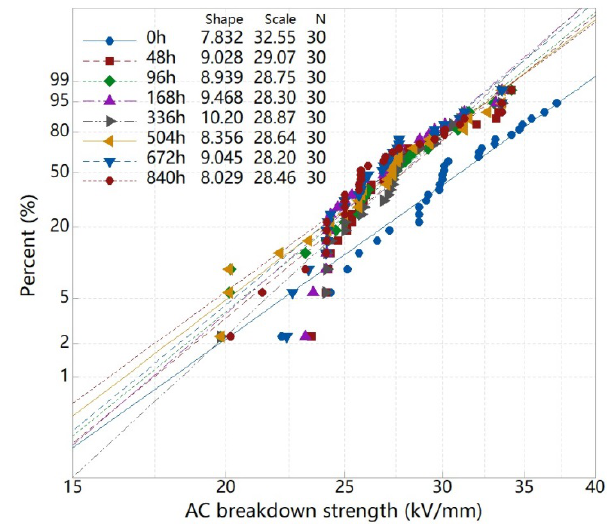
Figure 5. AC breakdown strength of samples with different aging time.